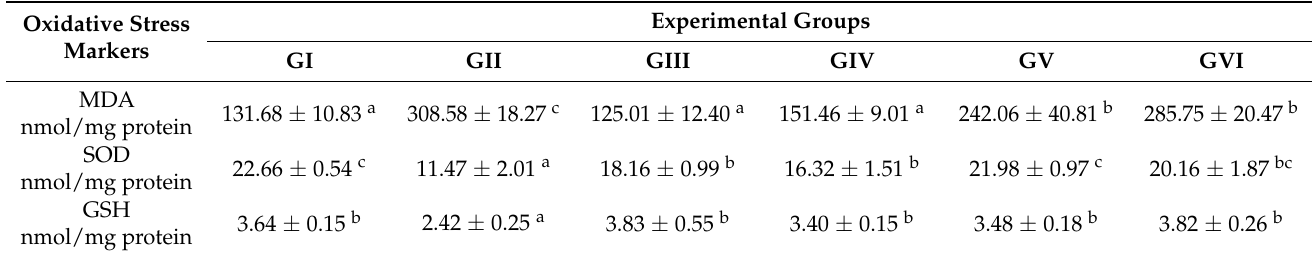
Table 4. Effects of oral administration of A. hierochuntica extracts on kidney oxidative damage in CCl 4 -induced toxicity in rats (mean ± SE), n =